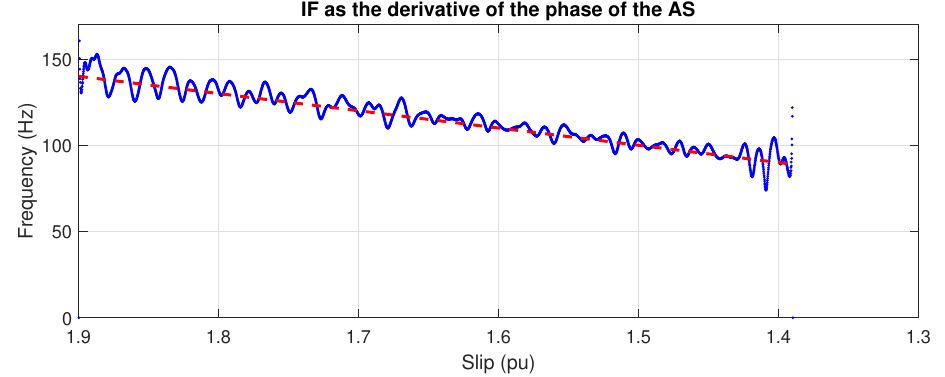
Figure 24. Instantaneous frequency of the LSH versus slip, under plugging conditions. Dashed, red line: theoretical evolution of the fault harmonic. Blue dots: evolution of the fault harmonic of the experimental